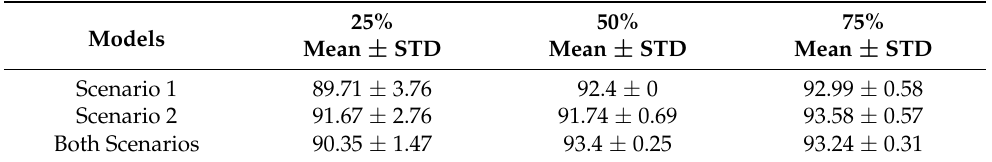
Table 5. Linear SVM classifier